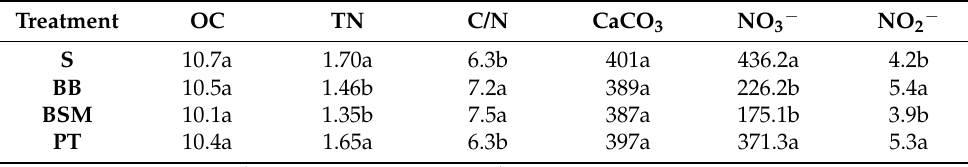
Table 4. Values of chemical indicators for the different